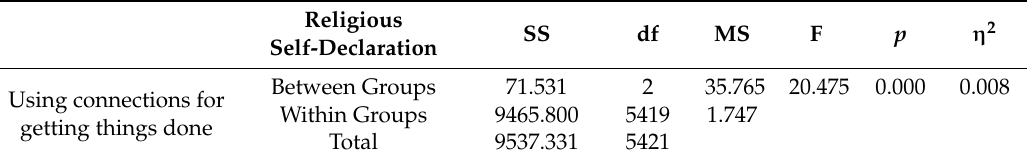
Table A7. Using connections for getting things done among religious self-declaration.